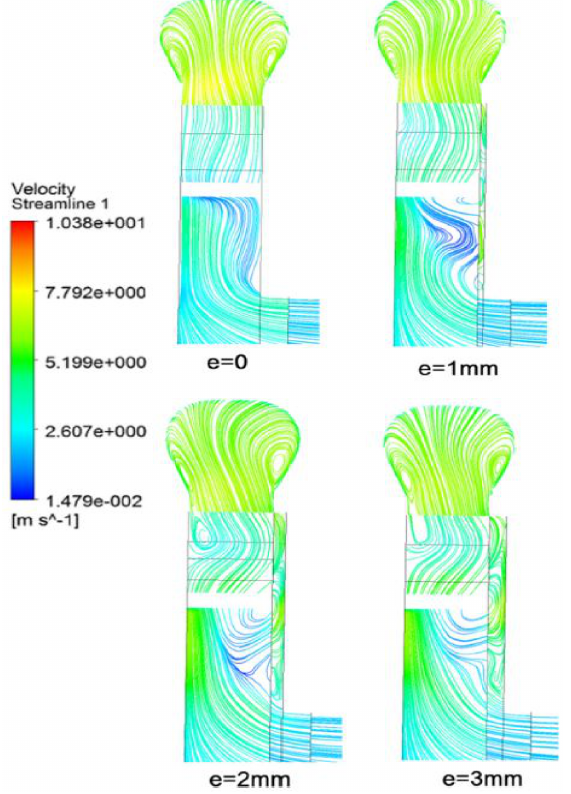
Figure 15. Velocity streamlines at a semi-open impeller